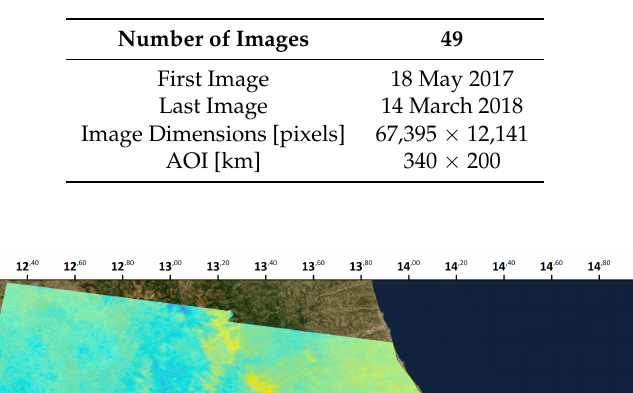
Figure 6. Sentinel observational data available for the Silvi Marina test case. Soil moisture in panel ( a , c ) (05 and 17 UTC), wind speed in panel ( b , d ) (05 and 17 UTC) and Sea Surface Temperature (00 UTC of 14 November) in panel ( e ). Table 2. Details of the images processed for Silvi Marina test case.